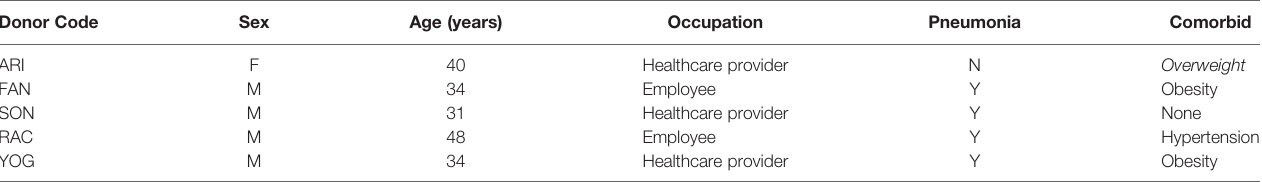
TABLE 1 | Epidemiology of repetitive convalescent plasma donors. Donor